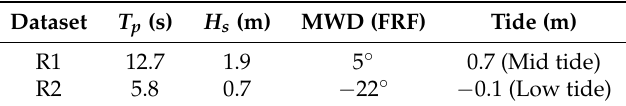
Figure 4. FOV of each camera for datasets in R1 and R2, ( right ) and ( left ) panel respectively. White lines denote camera boundaries, and green boxes denote the sandbar. Table 1. Summary of wave